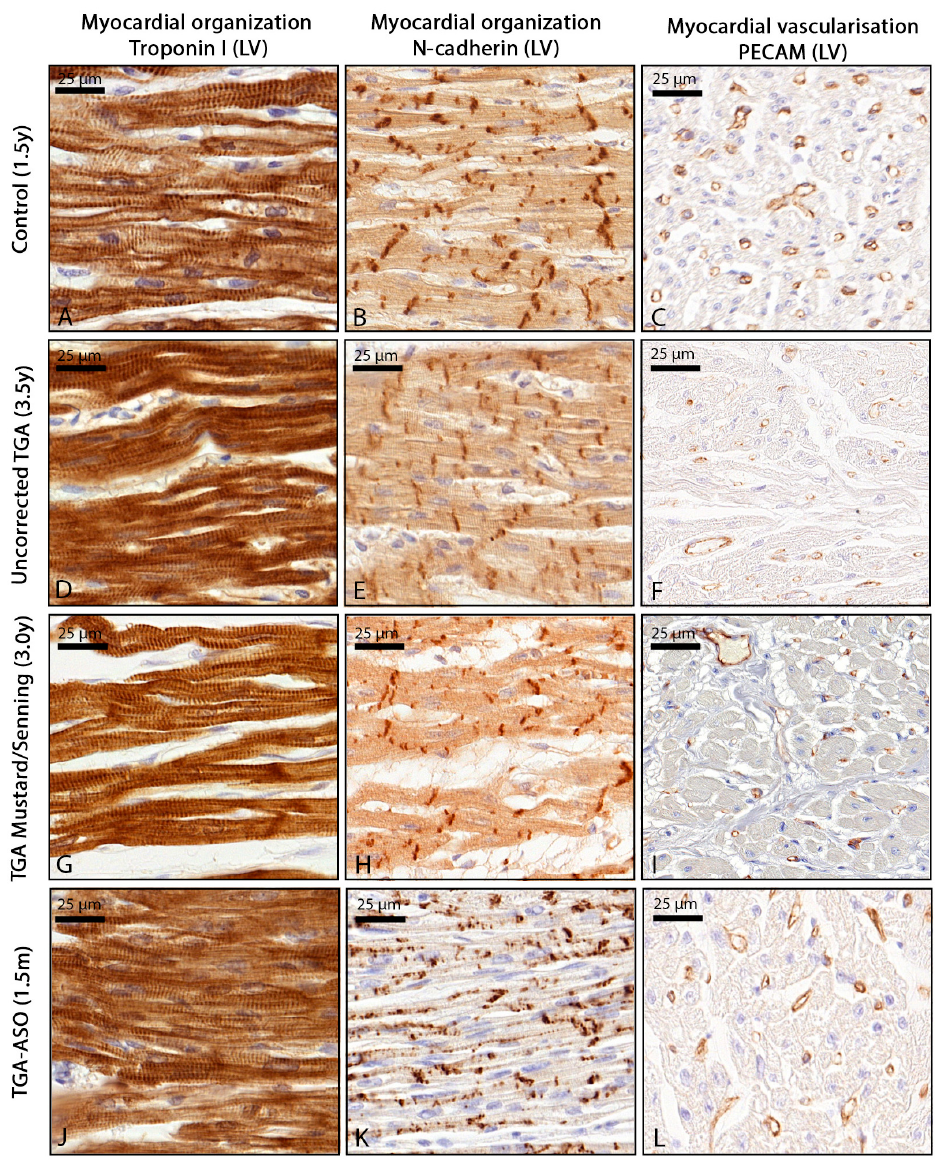
Figure 5. Myocardial organization and vascularization in control, uncorrected TGA, TGA-Mustard/Senning, and TGA-ASO specimens . Control; well-organized cardiomyocyte network ( A ) with expression of NCAD at the intercalated disk ( B ) and homogeneous distribution of capillaries ( C ). Uncorrected TGA; Well organized network of cardiomyocytes ( D ), slightly increased expression of NCAD, mostly located at the intercalated disk ( E ), and less homogeneous capillary distribution ( F ). TGA-Mustard/Senning; increased amount of extracellular matrix ( G ), normal distribution of NCAD at the intercalated disk ( H ), and normal capillary distribution ( I ) TGA-ASO; cardiomyocytes are well aligned ( J ) with increased NCAD distribution at the intercalated disk and lateral borders of the cardiomyocyte ( K ) and decreased amount of capillary distribution ( L ). Abbreviations: ASO, arterial switch operation; d, days; m, months; TGA, transposition of the great arteries; y = years.